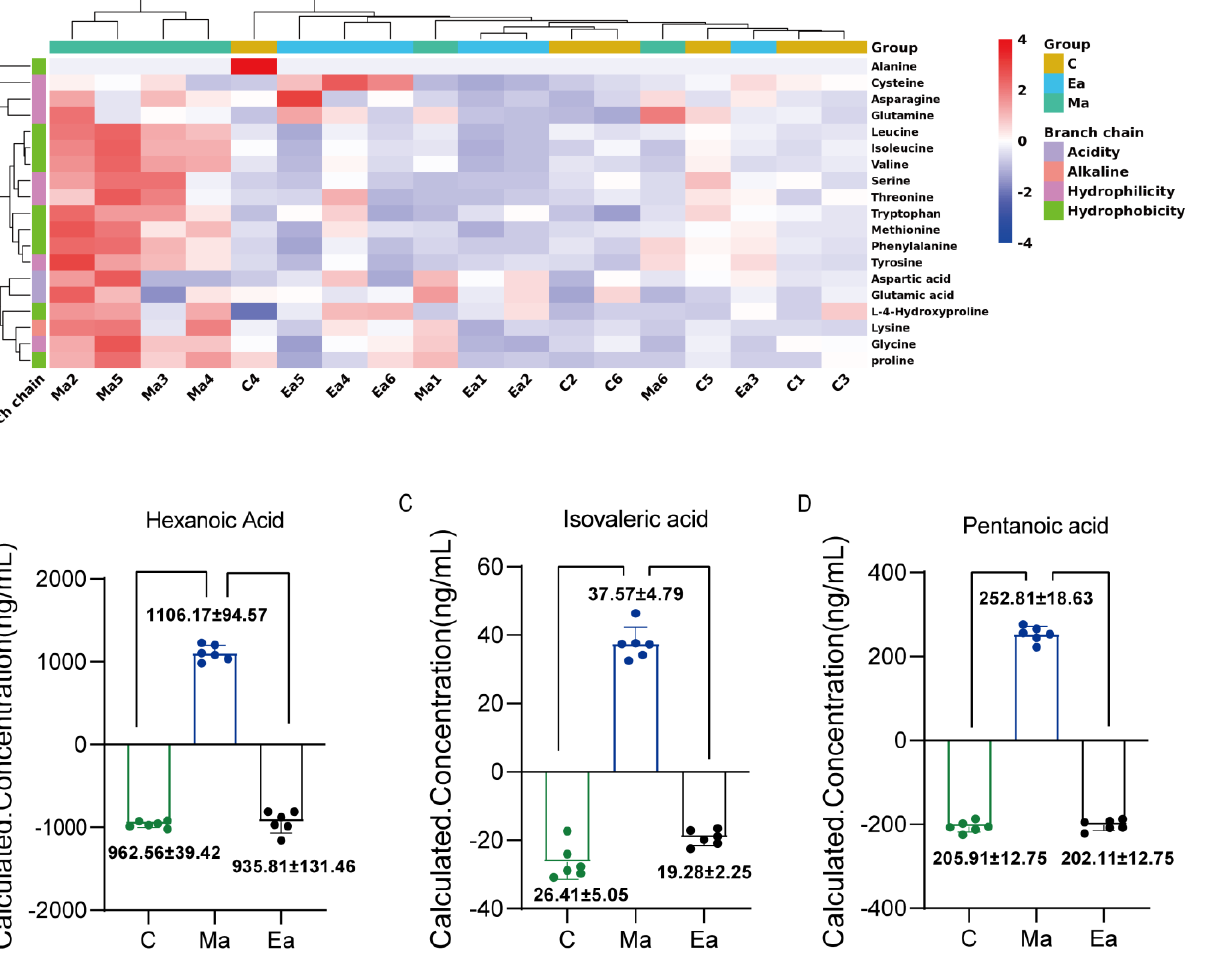
Figure 4. Comparison of concentration levels of intestinal metabolites SCFAs and amino acids among three groups of mice. ( A ) Changes in the levels of 19 amino acids in the intestine of three groups of mice; ( B ) Hexanoic acid content of mice in each group; ( C ) Isovaleric acid content of mice in each group; ( D ) Pentanoic acid content of mice in each group. * Indicates group Ma compared with group C, p < 0.05, ** indicates group Ma compared with group C, p < 0.01; # indicates group Ma compared with group C, p < 0.05; ## indicates group Ma compared with group C, p < 0.01. Table 2. The relationship of amino acid level changes between the three groups of mice.